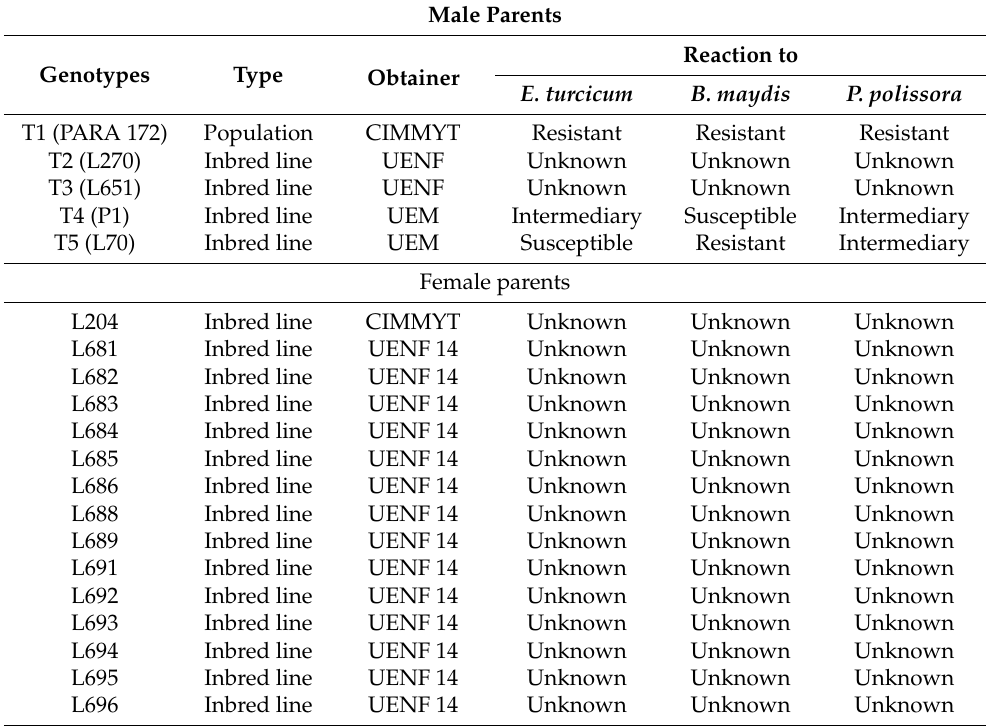
Table 1. Description of inbred lines and testers regarding the response to the pathogenic agents E. turcicum , B. maydis , and P. polysora